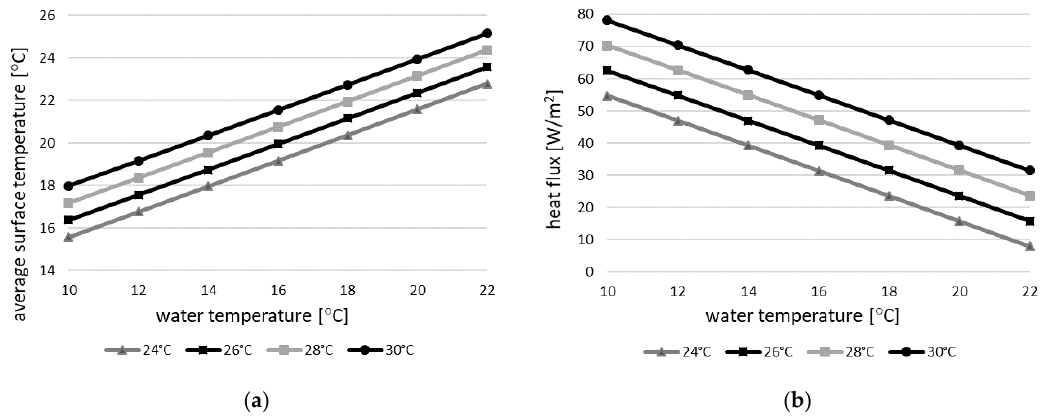
Figure 2. Relation between ( a ) average surface temperature on the cooling floor; ( b ) heat flux on the surface of the cooling floor, and temperature of the cooling medium for variable room temperature (pipe spacing 0.1 m, thermal resistance of floor covering 0.02 m 2 K/W).